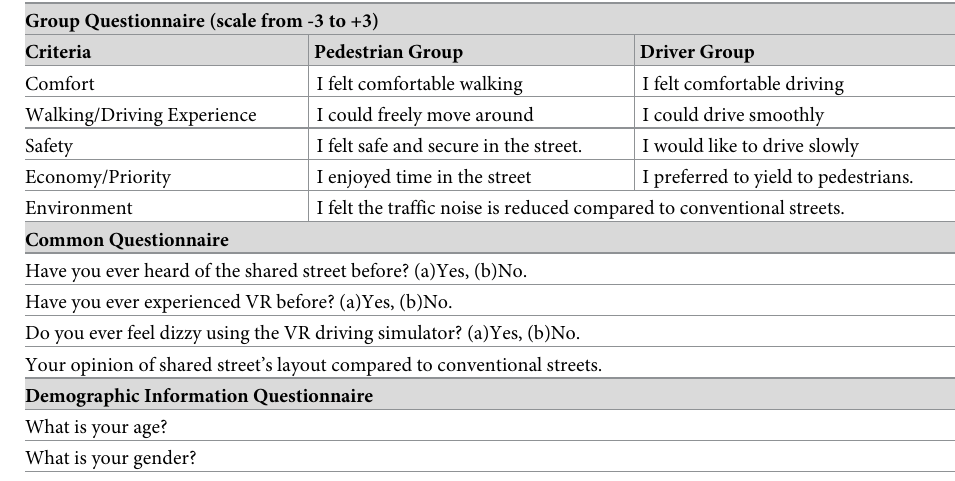
Table 2. Design of questionnaire survey.